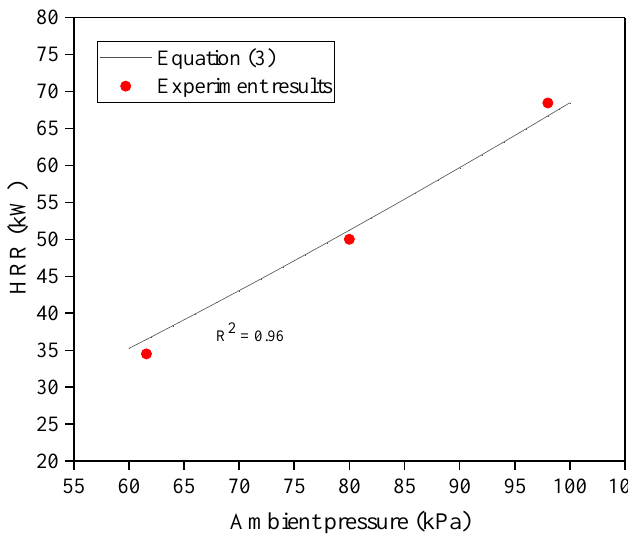
Figure 8. Relationship between ambient pressure and HRR.